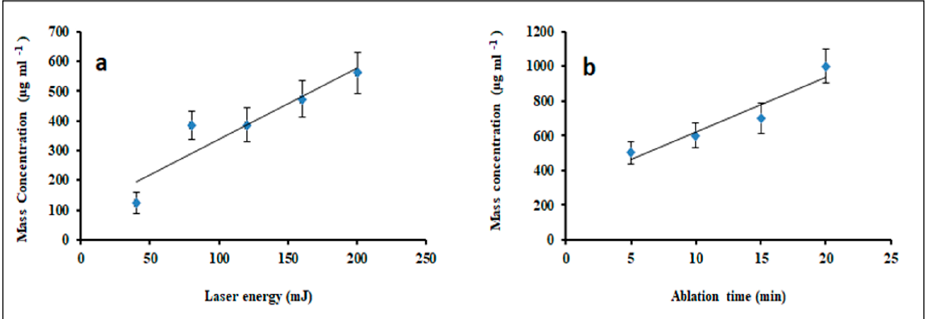
Figure 3. Mass concentration of TiO 2 NPs at different ( a ) laser energies and ( b ) ablation time.